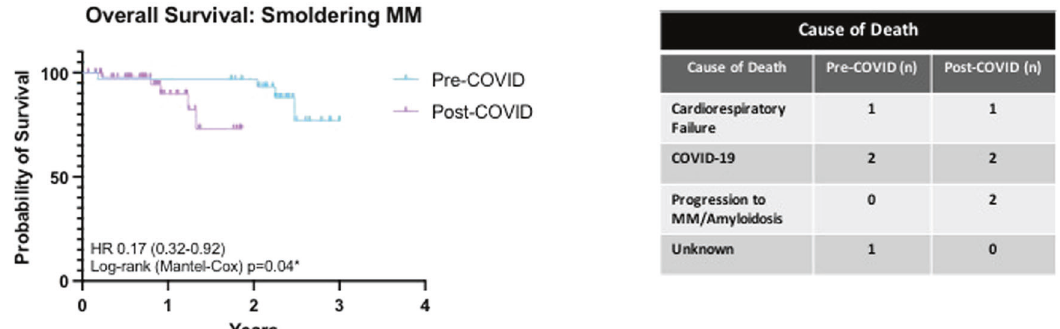
Fig. 8 Overall survival (OS) of patients with smoldering MM. Kaplan Meier estimate of overall survival of smouldering myeloma patients diagnosed from 1st January 2019 – 31st January 2020 (Pre-COVID, n = 31) and from 1st February 2020 – 31st July 2021 (Post-COVID, n = 49). Table - Cause of death of smouldering myeloma patients according to timing of